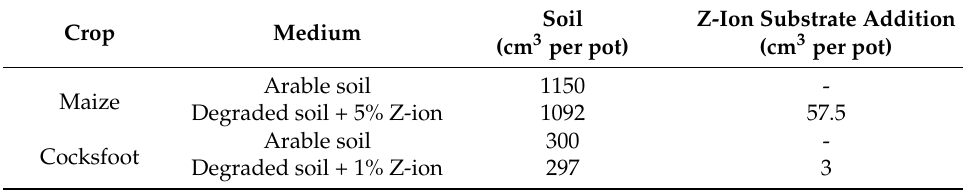
Table 2. Characteristics of growing media used for cultivation of the tested plants.